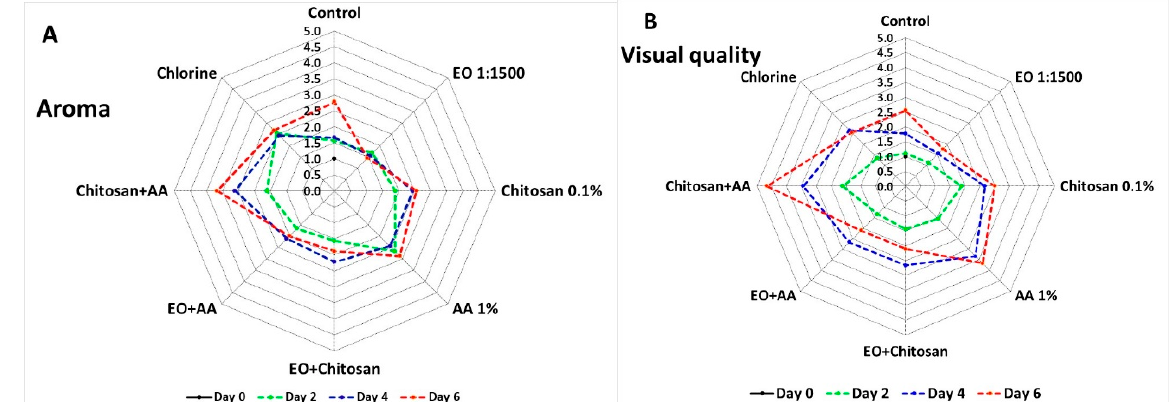
Figure 9. Effects of marjoram essential oil (EO), chitosan, ascorbic acid (AA) alone, and their combinations on fresh-cut lettuce ( A ) aroma (scale range from 1—lettuce like to 5—not lettuce, not acceptable) and ( B ) color/visual quality (scale: 1—green; 3—light discoloration; 5—severe browning) after 6 days of storage at 7 °C and 90% RH. Values represent means of evaluations made by 7 untrained panelists.